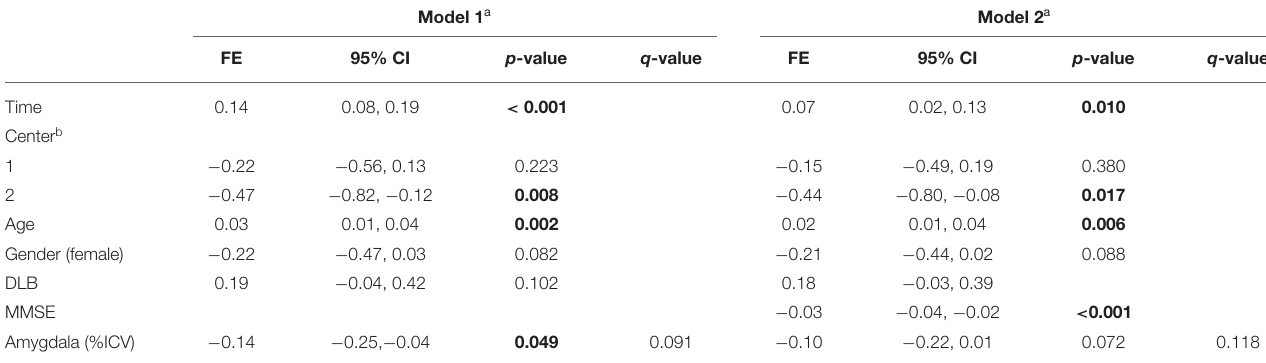
TABLE 2A | Amygdala volume and the Neuropsychiatric Inventory total score over 5 years.